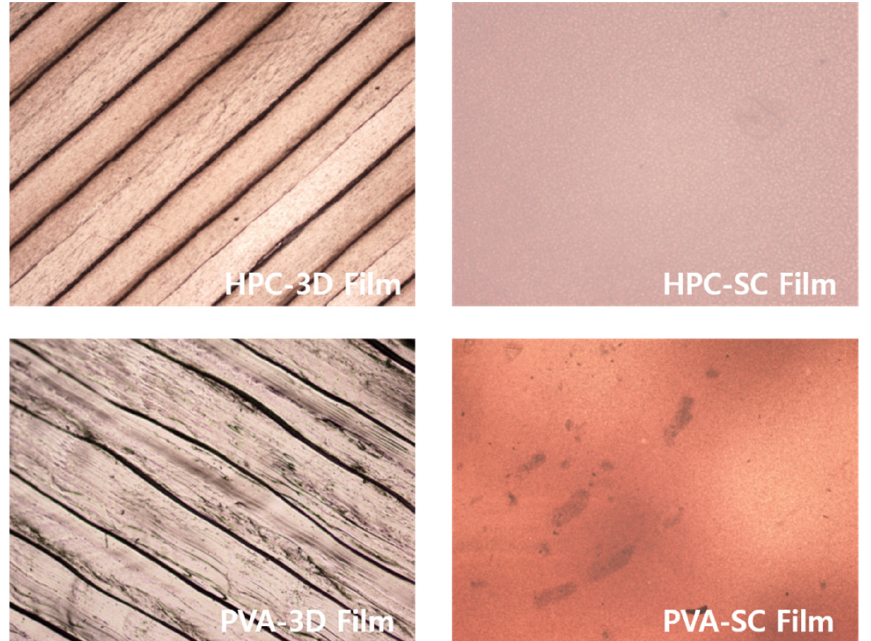
Figure 6. Optical microscopy images of the 3D-printed and solvent-cast films.